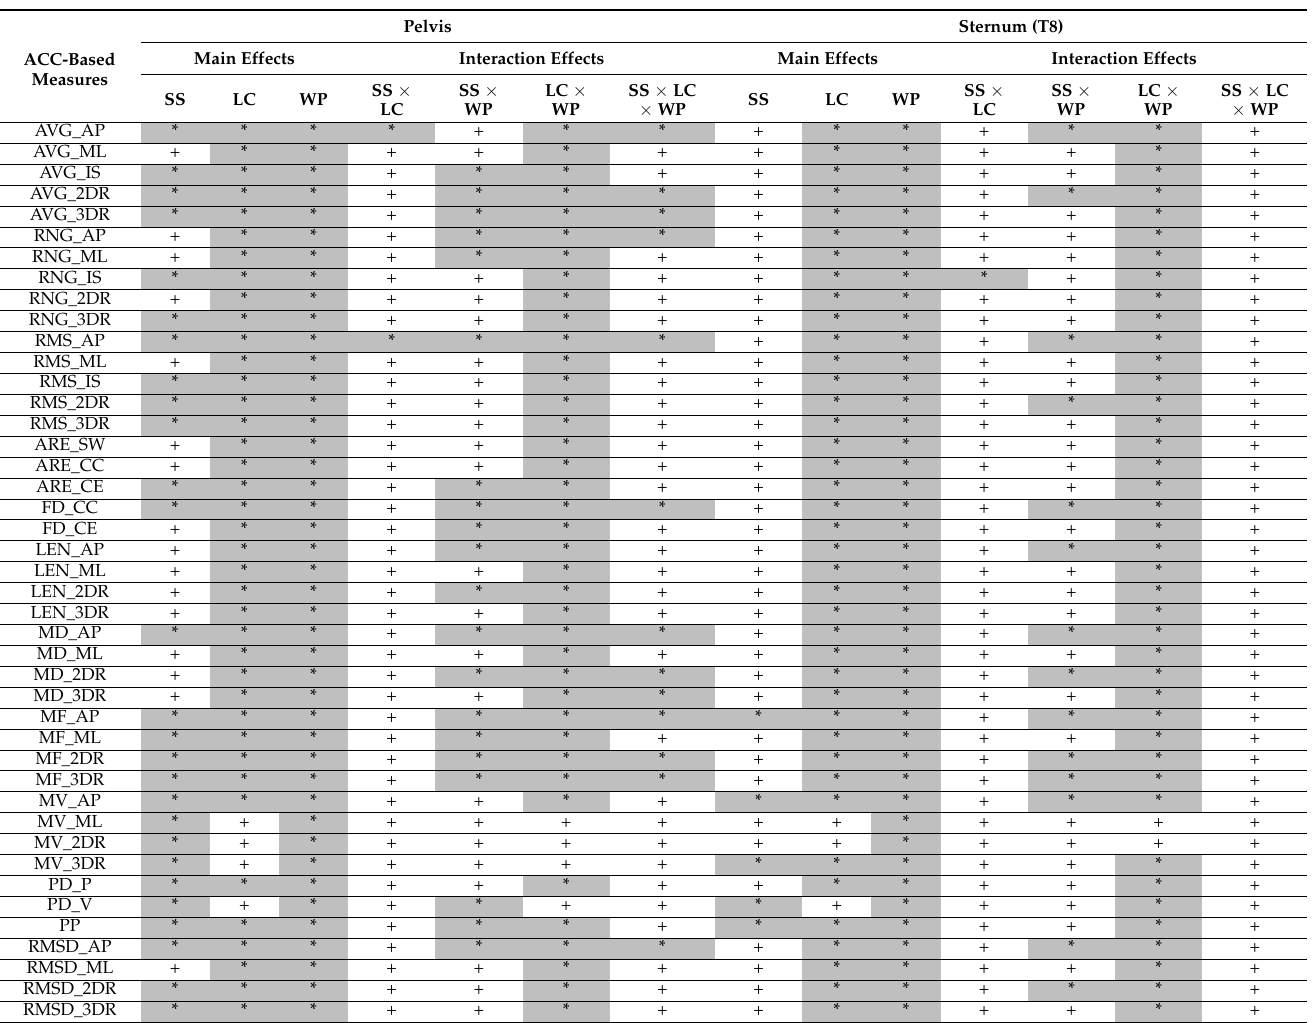
Table A1. Results 1 of t -tests and Analysis of variance using the acceleration data of Pelvis and T8.